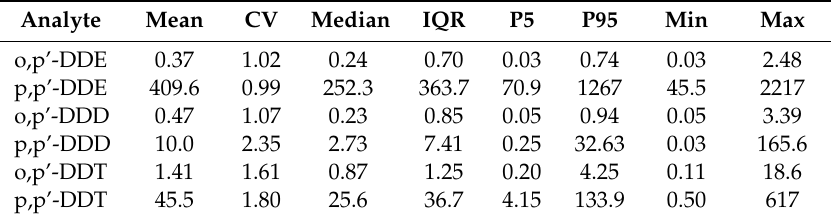
Figure 3. Frequency distributions of the concentrations of PBDEs in human fat tissue.